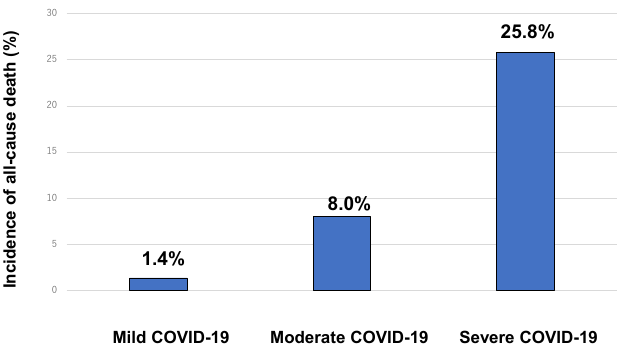
Figure 1. Incidence of all-cause mortality according to the COVID-19 severity on admission. Patients with mild, moderate, and severe COVID-19 were de fi ned as those who did not require oxygen, required oxygen, and required mechanical ven- tilation or extracorporeal membrane